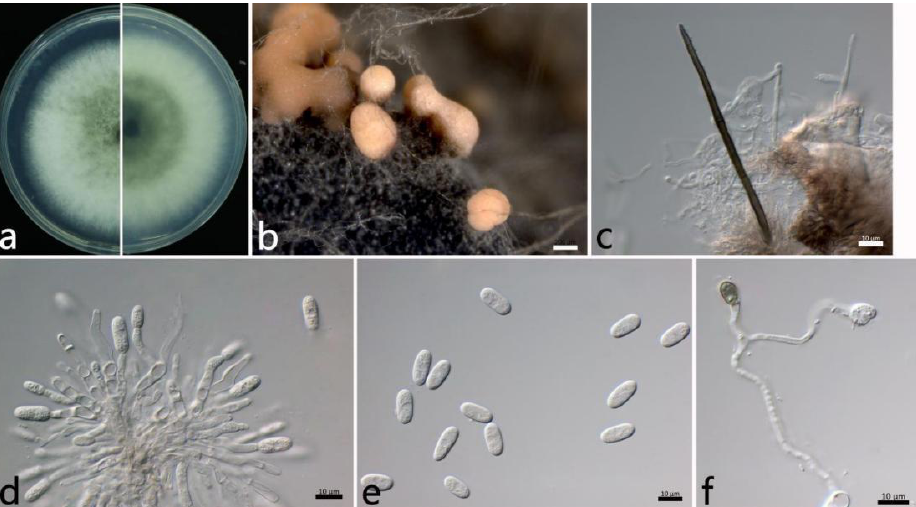
Figure 6. The morphological characteristics of Colletotrichum siamense (NL1-13) isolated from anthracnose leaves of Salix babylonica . ( a ) Colony on PDA from above and below (5 d). ( b ) Conidial masses (on PDA). ( c ) Seta. ( d ) Conidiophores, conidiogenous cells, and conidia. ( e ) Conidia. ( f ) appressoria. Scale bars: ( b ) = 200 µm; ( c – f ) = 10 µm.